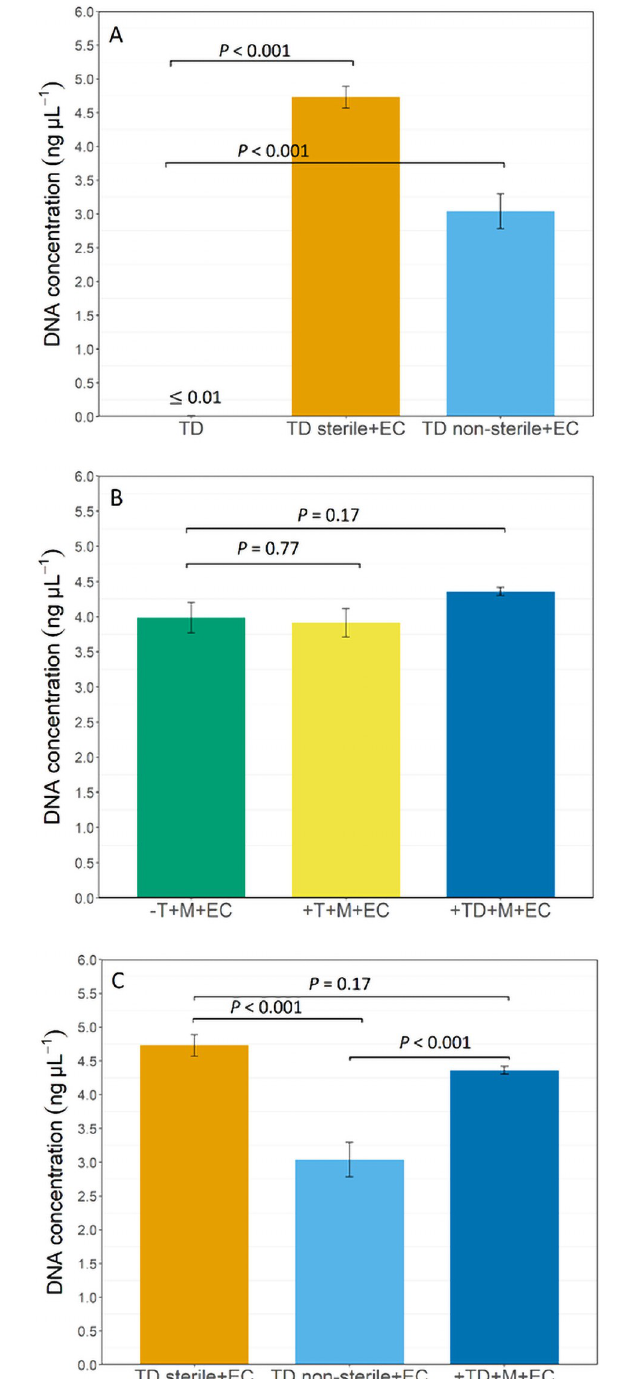
Fig 6. The extracted DNA concentration collected from dechlorinated tap water (A), membrane filters (B) spiked with Escherichia coli , and its subset (C) (sterile, non-sterile) dechlorinated tap water and membrane spiked with E . coli after filtration of dechlorinated tap water). + EC: Addition of Escherichia coli . TD: Dechlorinated tap water (addition of SMBS 10%). TD sterile: Dechlorinated tap water received prior membrane sterilization. TD non-sterile: Dechlorinated tap water without prior tap water sterilization.–T + M + EC: Membrane only (without tap water filtration) with the addition of E . coli . +T + M + EC: Membrane spiked with E . coli after filtration of tap water (residual chlorine). +TD + M + EC: Membrane spiked with E . coli after filtration of dechlorinated tap water. The error bars show errors from triplicate samples. P -value was shown for pairwise comparison (vs. control designees) based on ANOVA and post hoc Tukey’s